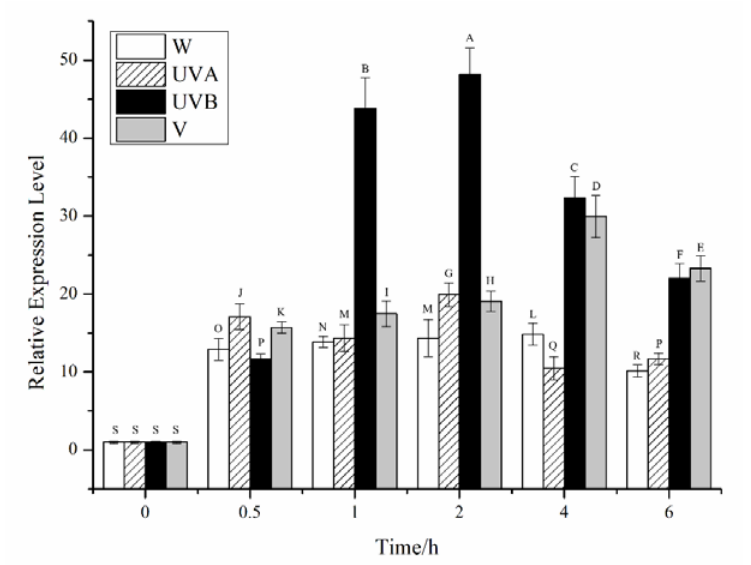
Figure 7. Relative expression of the CiPlant-CRY1 in different ultraviolet lights for different times. W: white light, UVA: UVA irradiation, UVB: UVB irradiation, V: violet light. Standard error bars are shown, n = 3. Different capital letters indicate significant differences between different treatments ( p < 0.01).